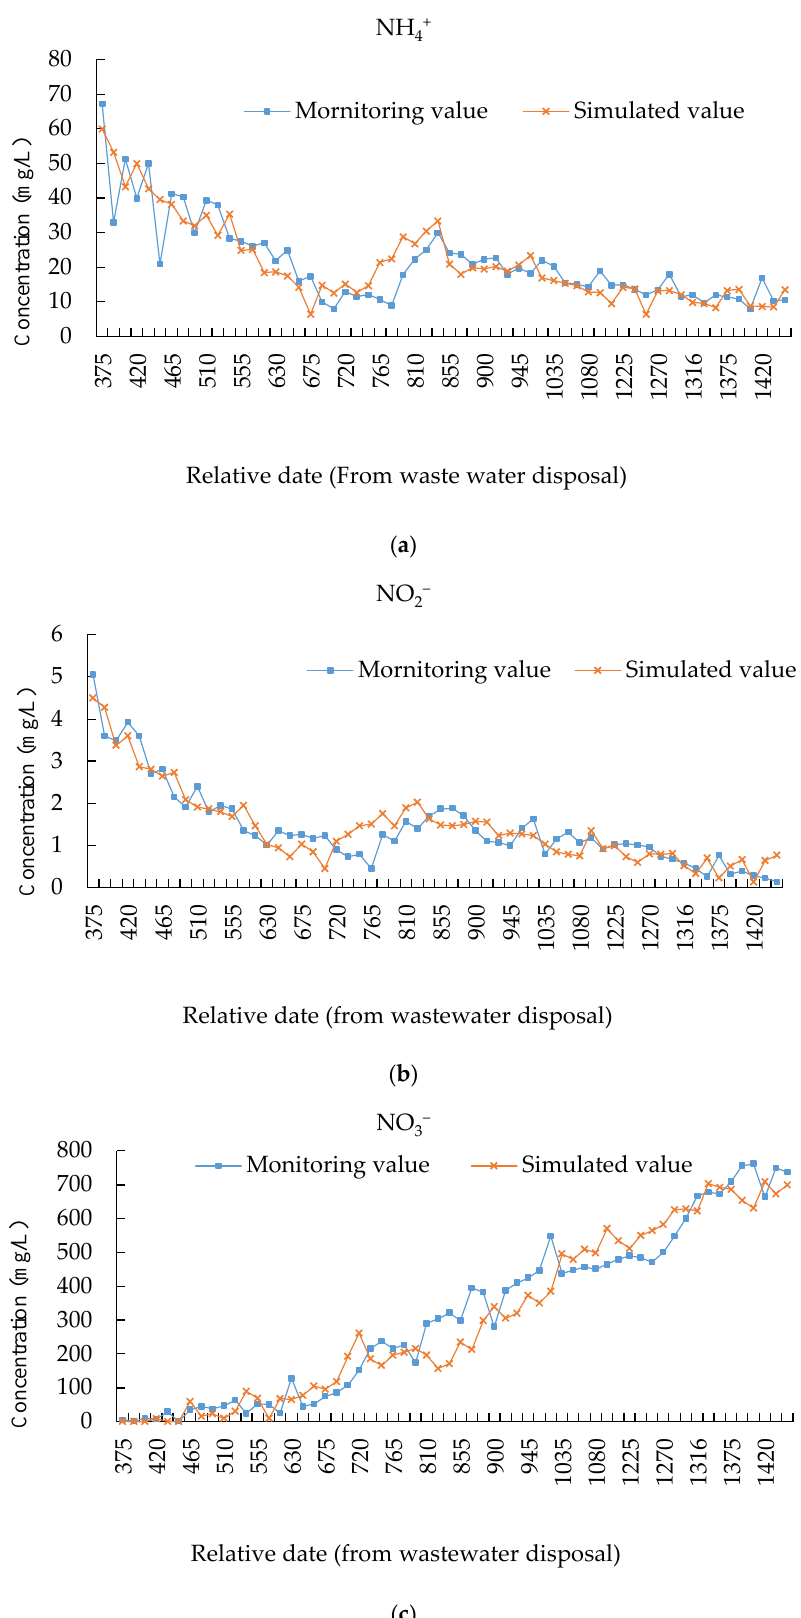
Figure 3. Model validation: simulated versus monitored values for ( a ) NH 4 + ; ( b ) NO 2 − ; and ( c ) NO 3 −